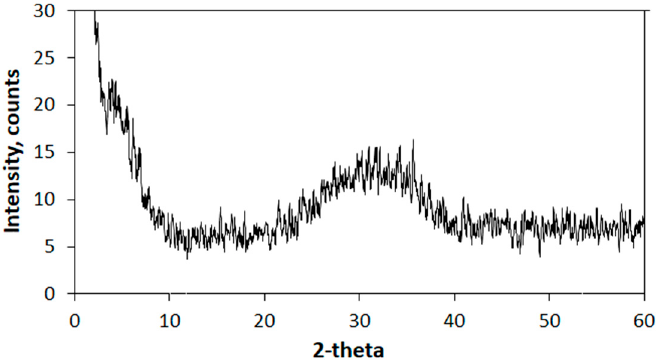
Figure 2. XRD pattern of copper slag.